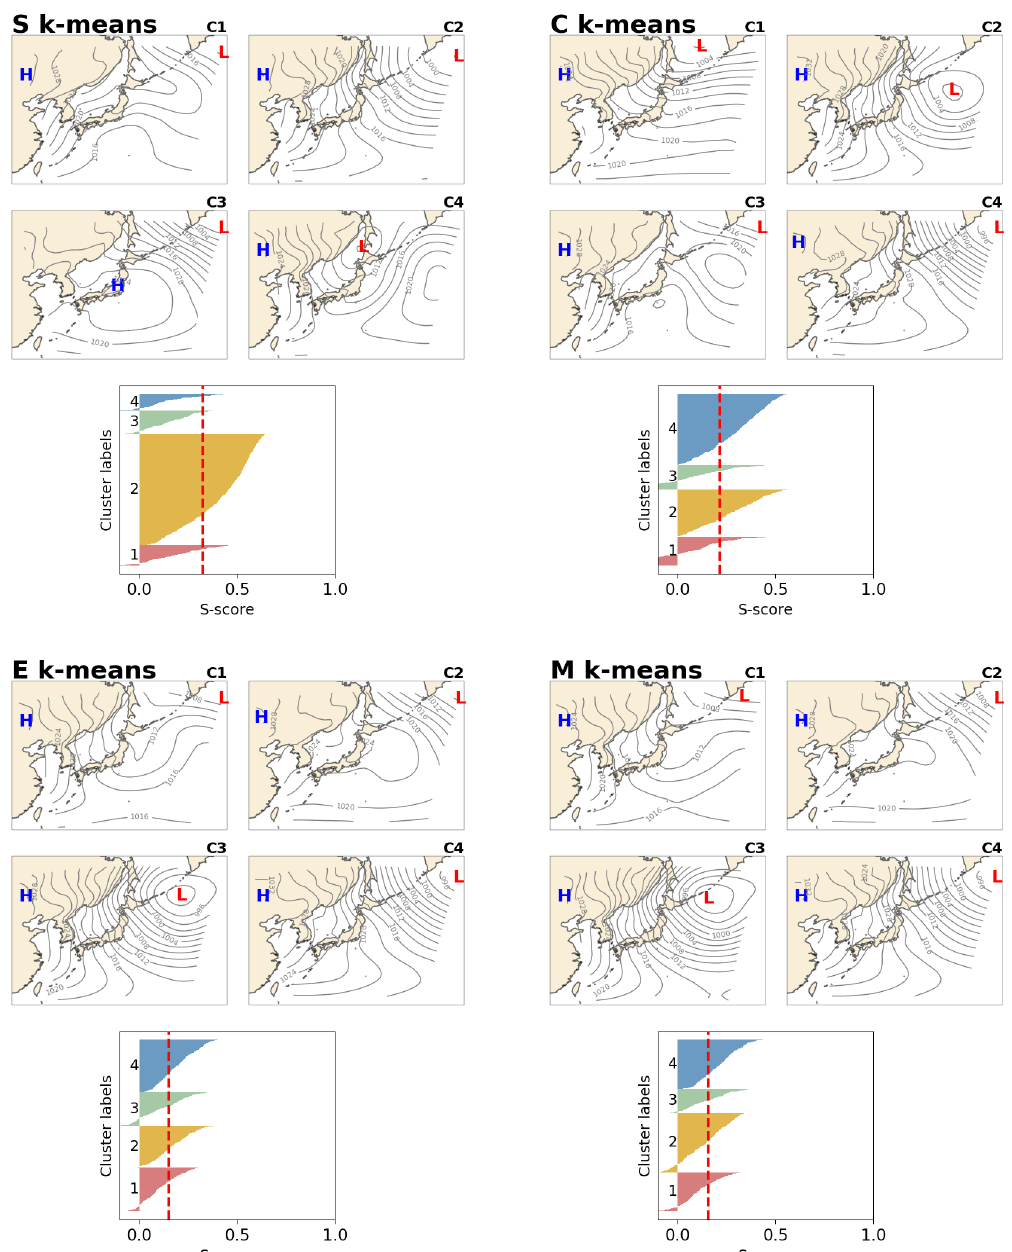
Figure 3. Result for the WP experiment. The winter SLP pattern revealed by S, C, E, and M k -means with k = 4. “H” indicates the location of the high, and “L” indicates the location of the low. General silhouette analysis results are shown below the maps, where the x axis indicates the score, and the y axis presents the labels of clusters numbered 1–4. Input data are ERA-Interim SLP data, which were re-gridded to Cartesian coordinates with a resolution of 200 × 200km and grid size of 35 × 35. Daily data for December, January, and February collected over 10 years (2005–2014) were